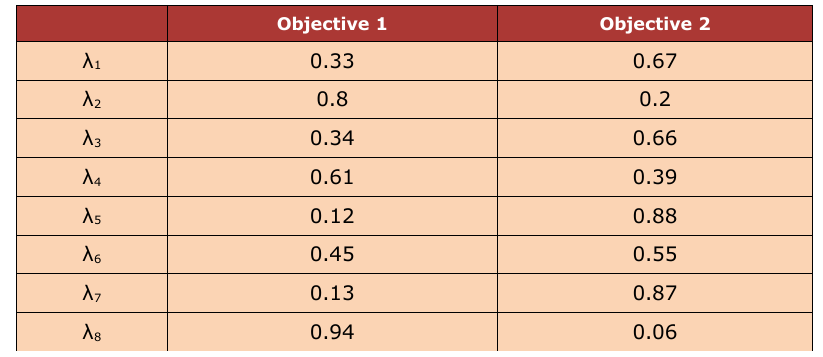
Table 10. Weight vectors for each